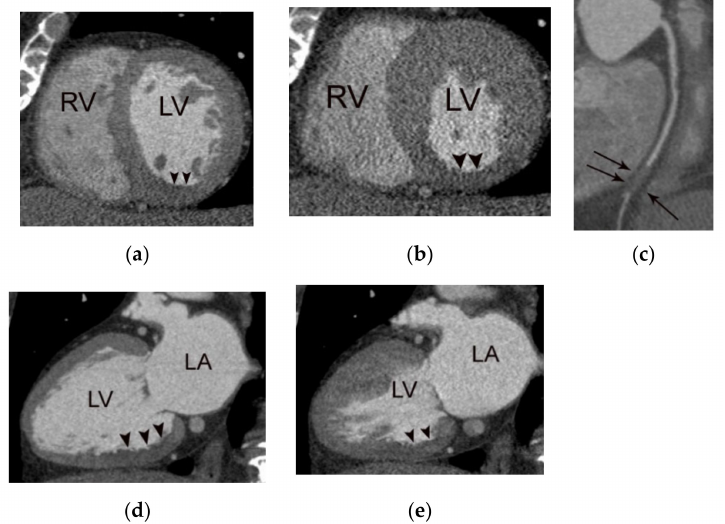
Figure 6. A case of acute myocardial infarction in a 60-year-old male patient. A. Note the akinesia (arrowheads) in the inferior wall of the mid to basal left ventricle in diastolic ( a , d ) and systolic images ( b , e ). Note the total occlusion in the distal right coronary artery (arrows in ( c )) with positive remodeling and fat stranding, resulting in an irregular interface between the coronary wall and epicardial fat. RV, LA, and LV indicate right ventricle, left atrium, and left ventricle,